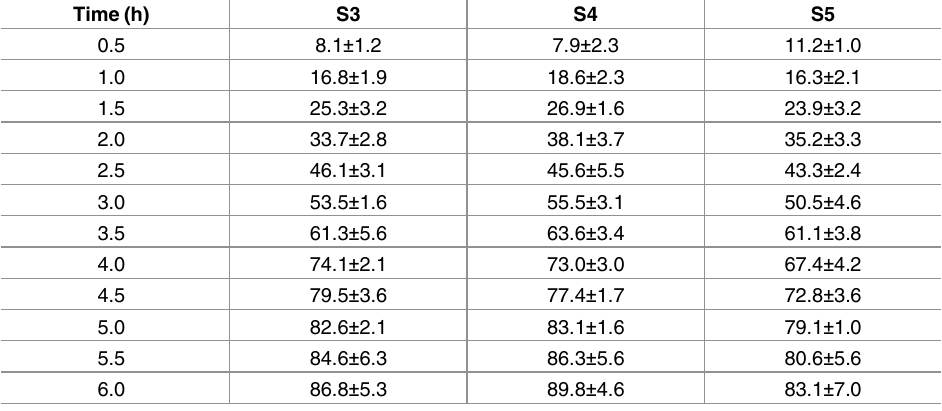
Table 10. Ex vivo cumulative permeation rate of geniposide from optimized